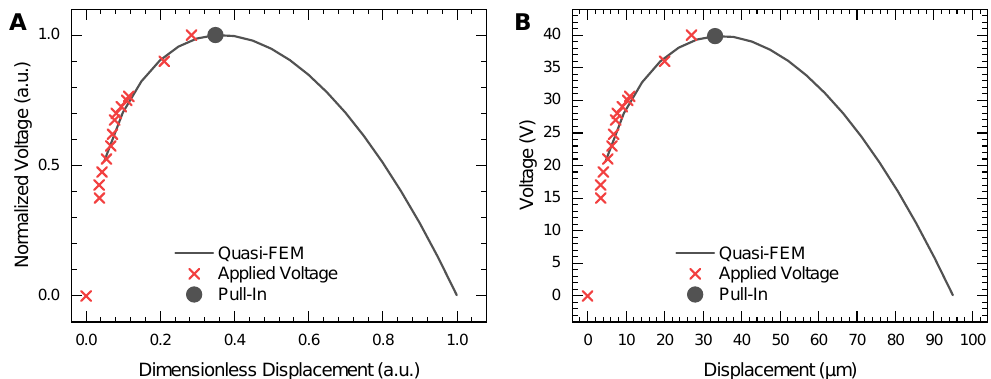
Figure 7. Results of modeling for PM with a 2800µm side length and thickness of 10µm Al: ( A ) normalized voltage vs. dimensionless displacement; ( B ) voltage vs. displacement in absolute